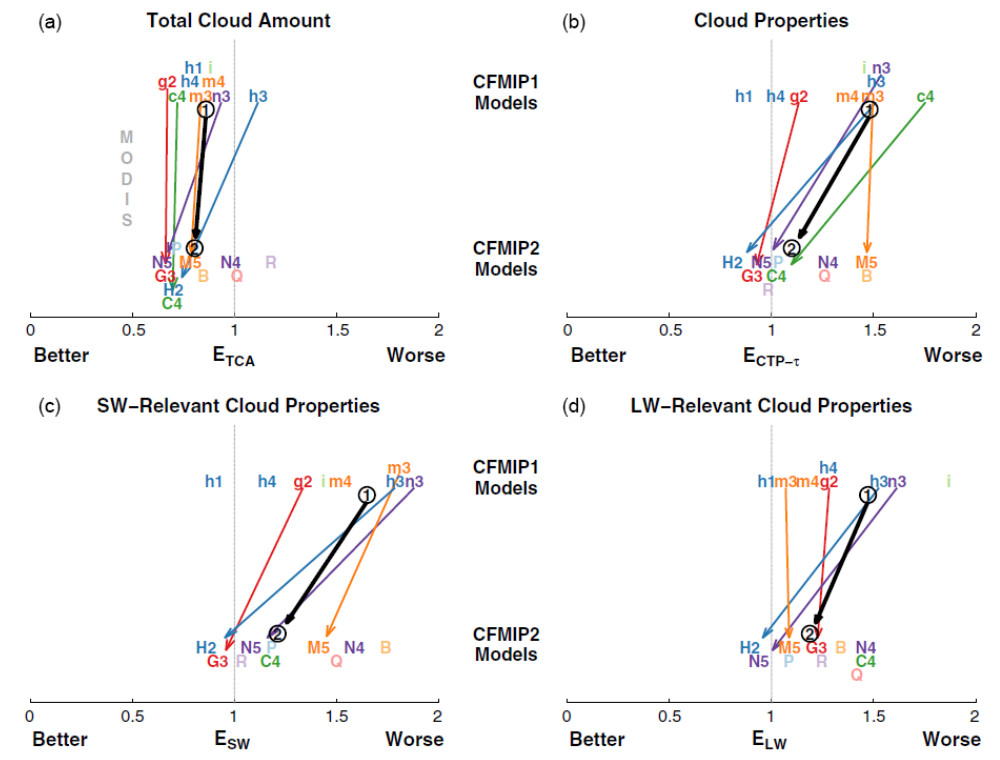
Figure 1. Scalar measures of fidelity of CFMIP model simulations in reproducing the space–time distribution of several cloud measures, with greater fidelity indicated by lower E values. E TCA (a) measures fidelity in simulating total cloud amount, whereas Ectp- τ (b) measures fidelity in simulating cloud-top pressure and optical depth in different categories of optically intermediate and thick clouds at high, middle, and low levels of the atmosphere. The impacts on top-of-atmosphere shortwave and longwave radiation in the same categories used for Ectp- τ are measured by E SW (c) and E LW (d) , respectively. Models are stratified vertically into the two ensembles and are plotted in different symbol keys. (To identify a model in a symbol key, see Klein et al., 2013.) For the modelling centres in which we can track progress, the arrow connects the oldest model in the family (arrow base) to the most recent model (arrow tip). The thick black arrow connects the average measure of CFMIP1 models (arrow base) to that of CFMIP2 models (arrow tip). Arrows pointing to the left indicate improvements with time. Reprinted from Klein et al.